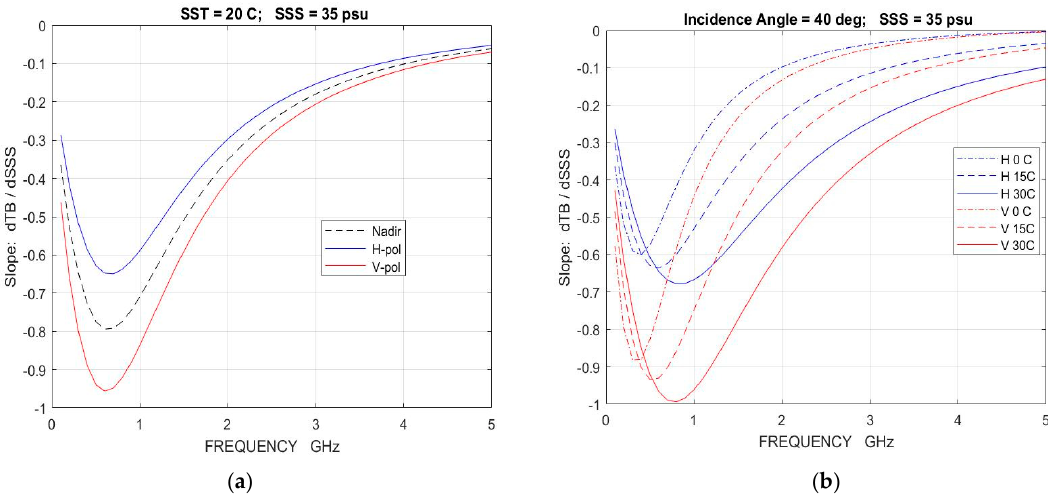
Figure 4. Sensitivity of brightness temperature, TB, to changes in salinity, SSS, as a function of frequency: ( a ) dependence on incidence angle (SST = 20 ◦ C; SSS = 35 psu); ( b ) dependence on SST at 40 ◦ incidence angle (SSS = 35 psu). These results are for a flat surface (no roughness) and use the Klein-Swift [19] model function for the dielectric constant of sea water. Above 5 GHz, the curves continue the reported trend and converge to 0.